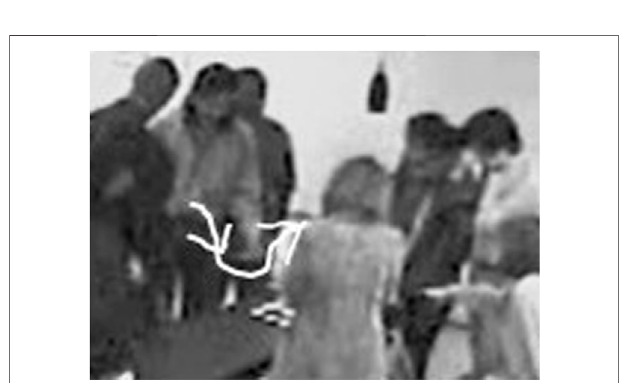
FIGURE 7 | You say the story a